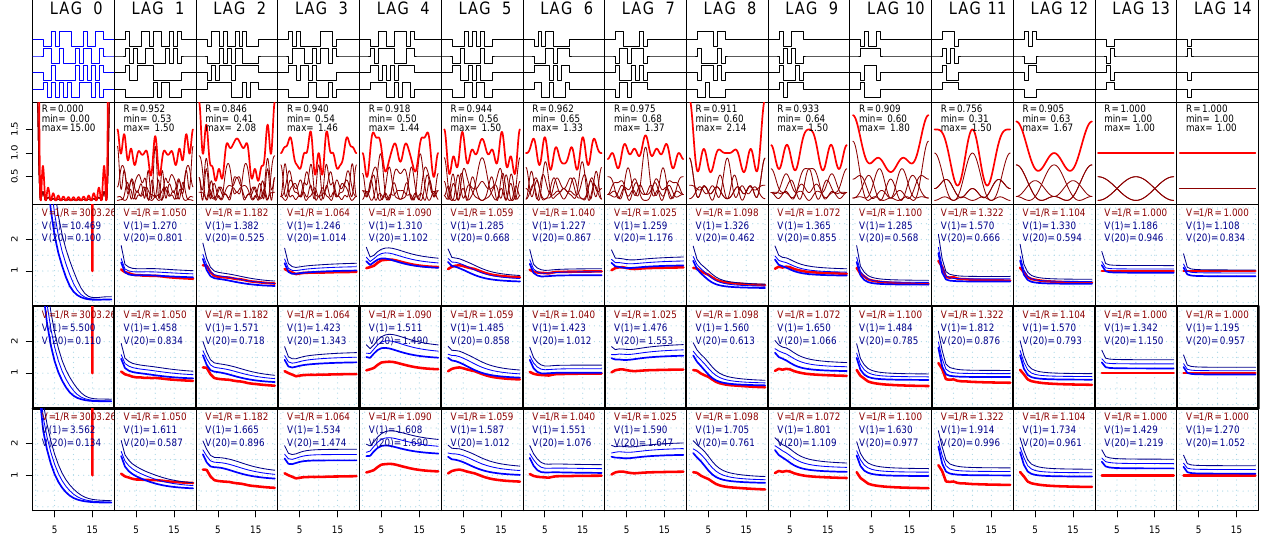
Fig. 4. Evaluation of the chosen code for a 15-baud 4-pulse experiment. While not perfect, the variances as function of range integration perform significantly better than in the previous figure with a randomly chosen code. For lags 2, 8, 10, 11 and 12 the variances go down faster than the range integration would imply. This is connected with the fact that the Fourier side information curve (red curve in the second row of panels) shows high values for DC and low frequencies.